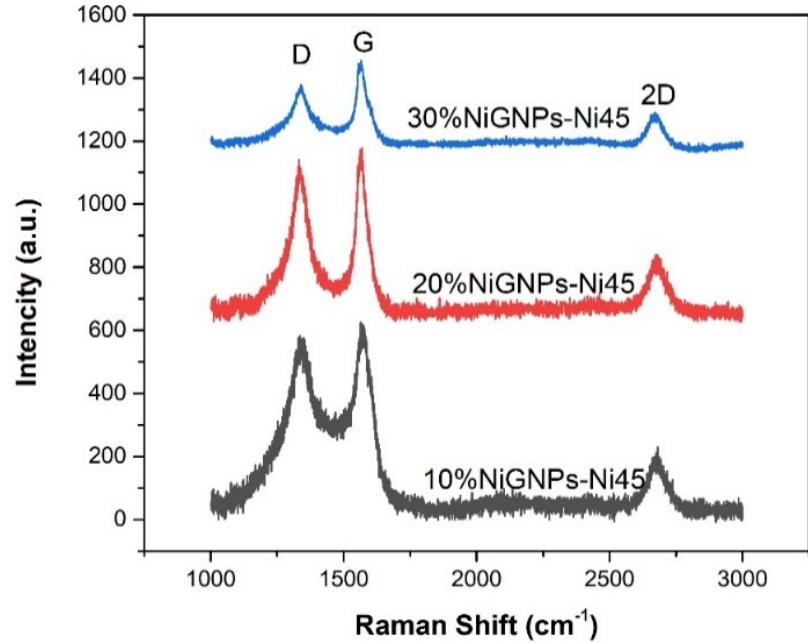
Figure 6. Raman analyses of GNPs in nickel-based graphene composite